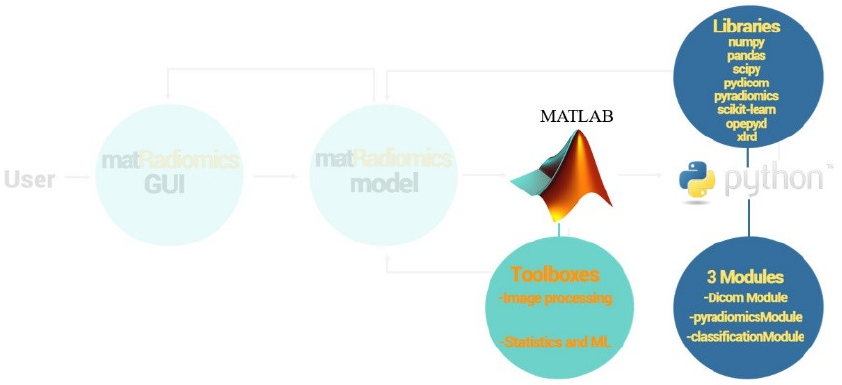
Figure 2. MATLAB toolboxes, python modules, and libraries.